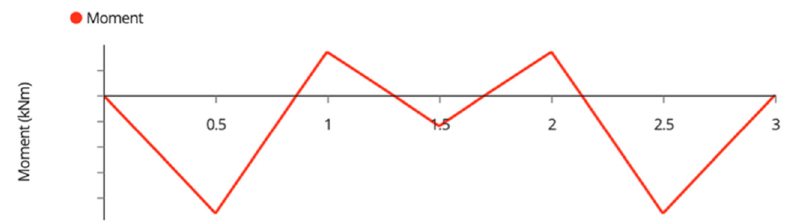
Figure A11. Beam bending moment diagram. The deflection diagram for each beam is shown in Figure A12.